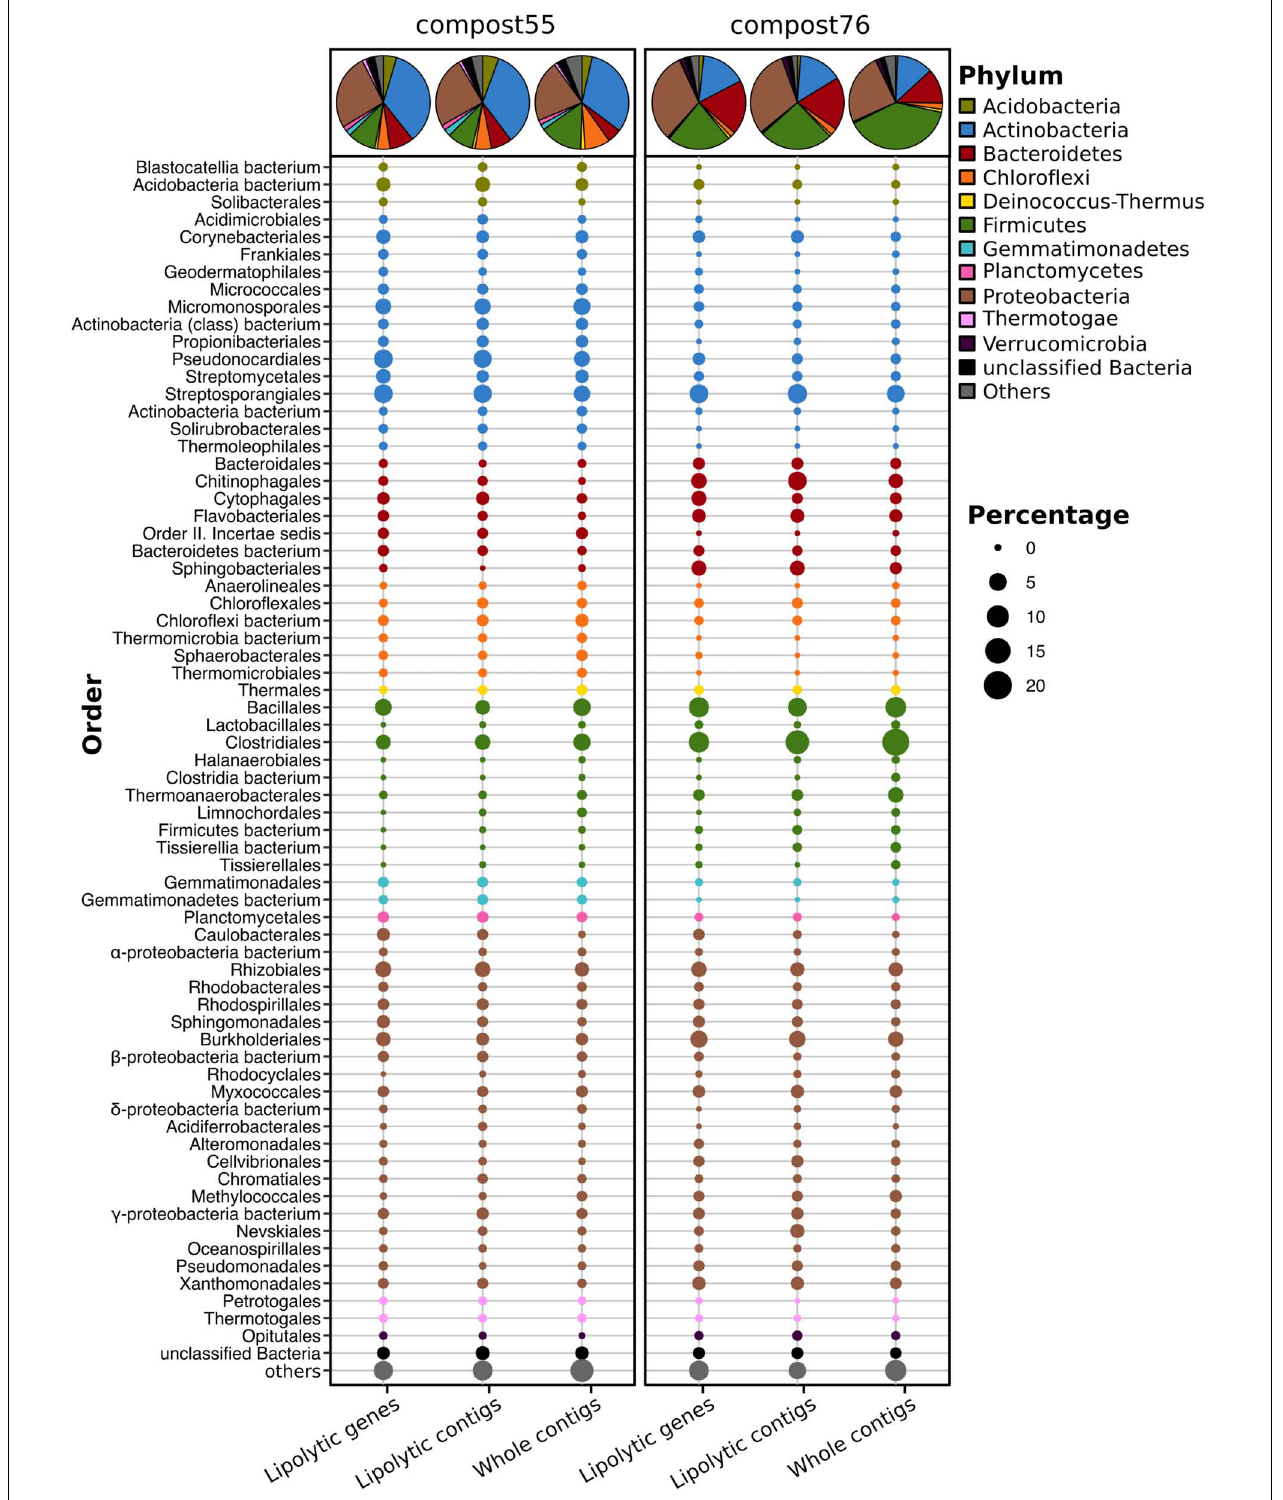
FIGURE 2 | Phylogenetic distribution of assigned PLP-encoding genes identified in compost55 and compost76 metagenomes. The phylogenetic origin of PLP-encoding genes, the contigs harboring these genes, and the whole assembled contigs were annotated by Kaiju (Menzel et al., 2016), and expressed as the proportion of the respective total counts in each sample. The pie charts represent the taxonomic composition at phylum level. Taxa with an abundance of less than 1% were grouped into “others.”